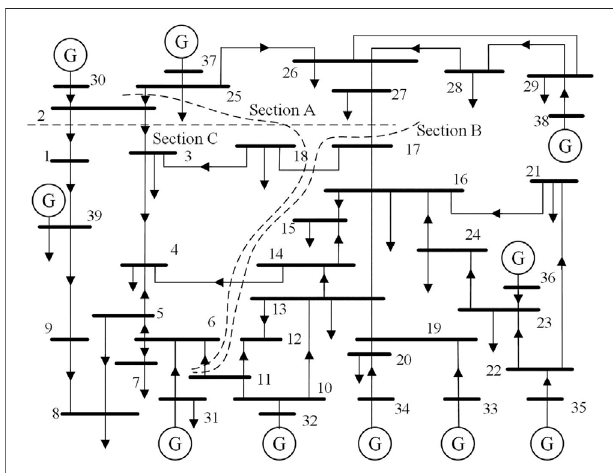
FIGURE 6 | IEEE 39-node system structure diagram.